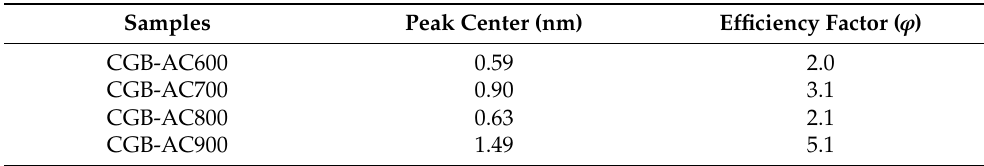
Table 3. Peak centers from pore size distribution analysis and the efficiency factor ( ϕ ) for hydrogen uptake for the CGB-AC